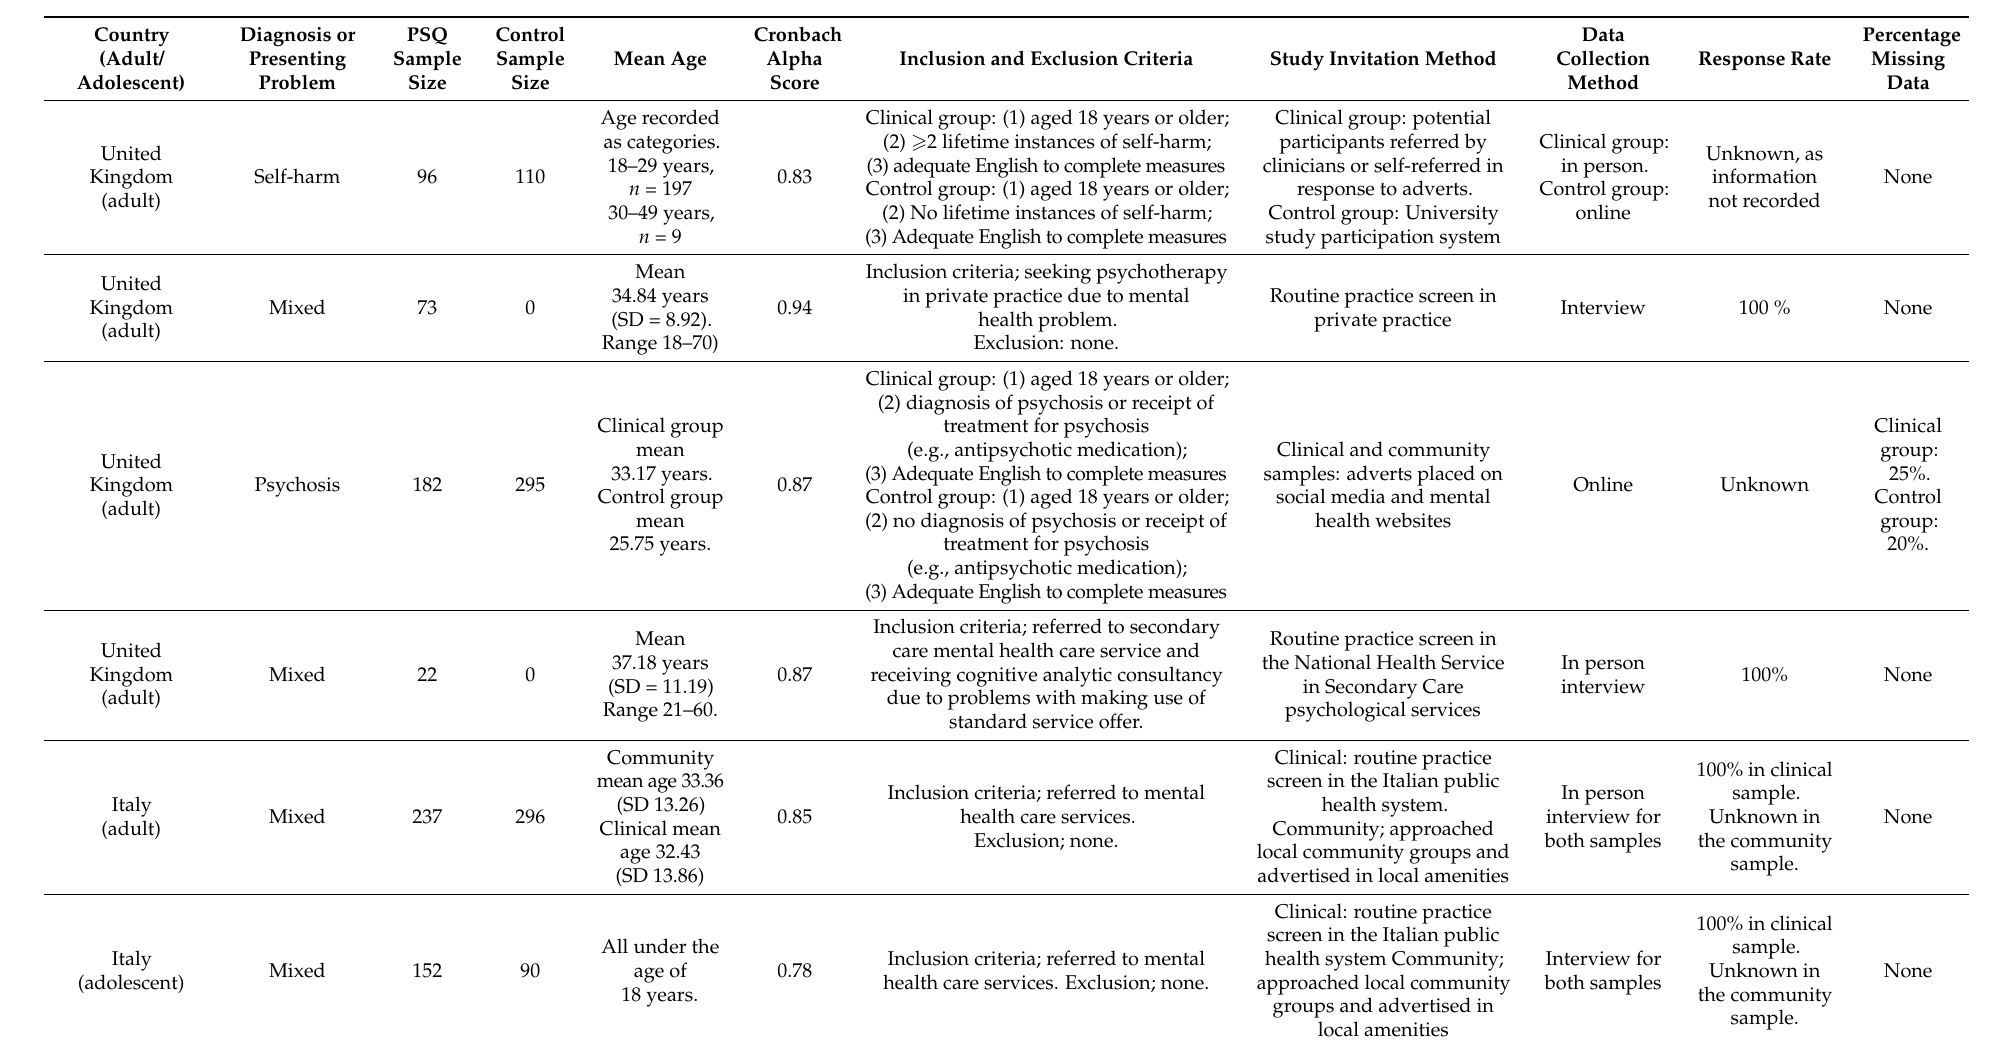
Table 1. Methodological features for each of the PSQ studies making up the